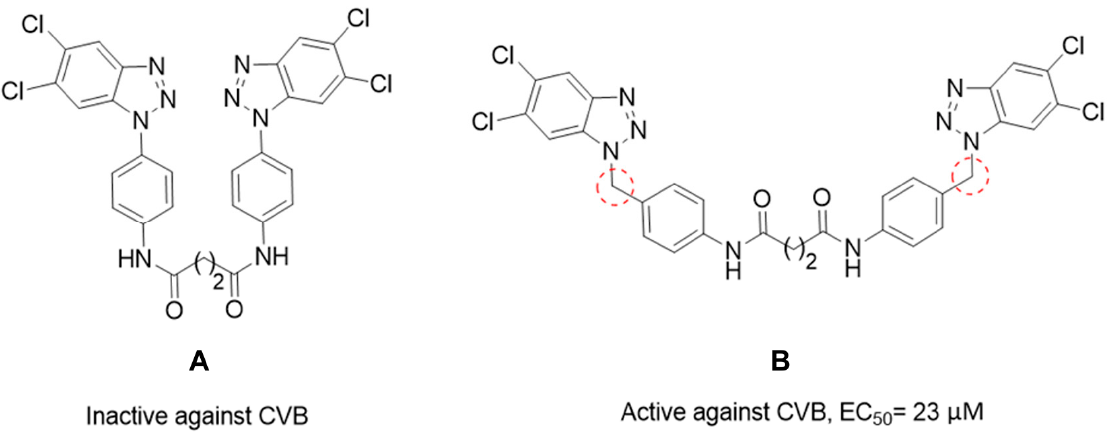
Figure 3. The precursor N1 , N4 -bis(4-(5,6-dichloro-1 H -benzo[ d ][1,2,3]triazol-1-yl)phenyl)succinamide ( A ) and its active derivative N1 , N4 -bis(4-((5,6-dichloro-1 H -benzo[ d ][1,2,3]triazol-1-yl)methyl)phenyl)succinamide ( B ).